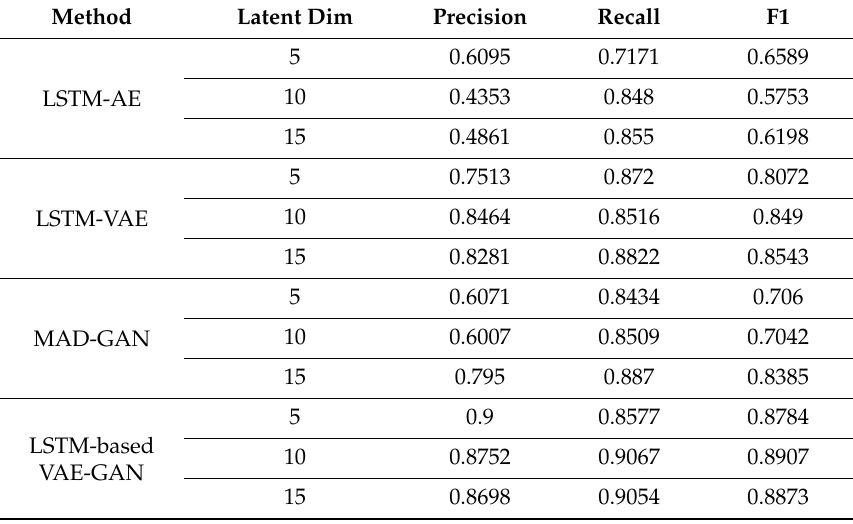
Table 2. The experiment results in di ff erent latent space’s dimensions in Yahoo dataset.